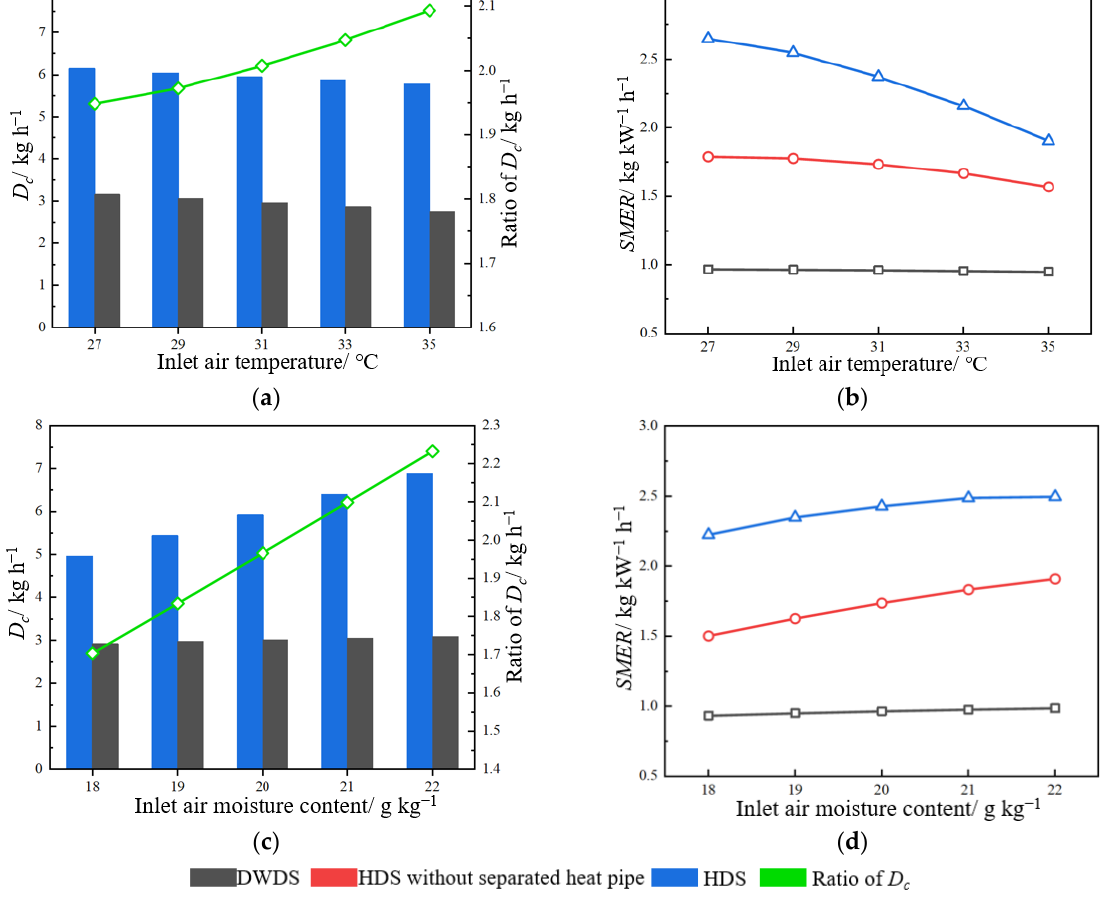
Figure 8. 𝐷 𝑐 and 𝑆𝑀𝐸𝑅 of three dehumidification systems . ( a ) 𝐷 𝑐 . ( b ) 𝑆𝑀𝐸𝑅 . ( c ) 𝐷 𝑐 . ( d ) Figure 8. D c and SMER of three dehumidification systems. ( a ) D c . ( b ) SMER . ( c ) D c . ( d ) SMER 𝑆𝑀𝐸𝑅 .